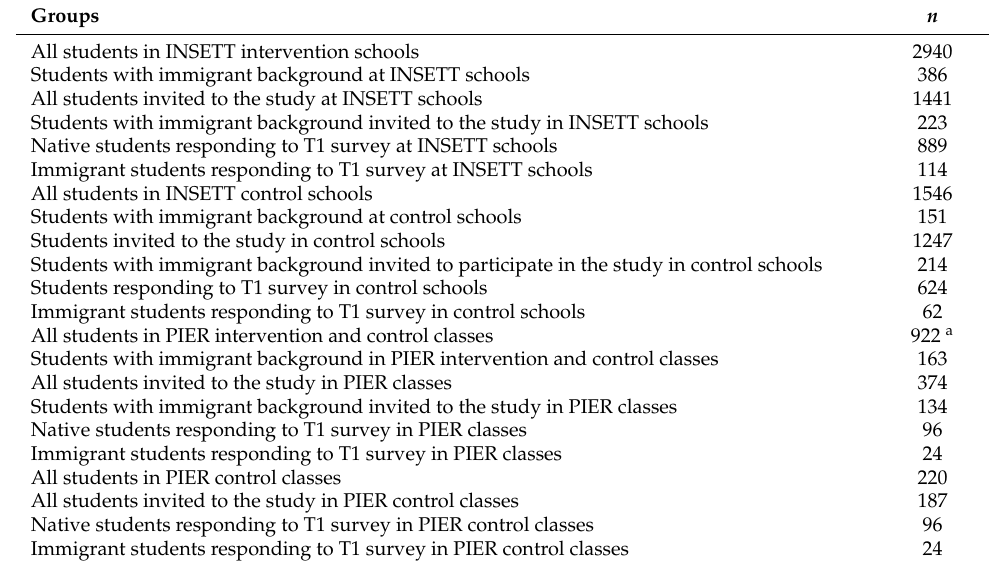
Table 1. Numbers of participants at baseline.